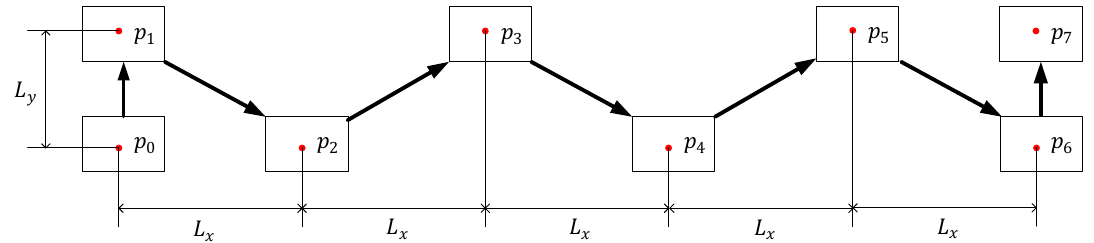
Figure 3. Setting of the landing points p 1 , p 2 , ··· , p N , which represent ZMPs for an inverted pendulum and determine the walking length L x and width L y . The rectangles represent the robot’s footprints.